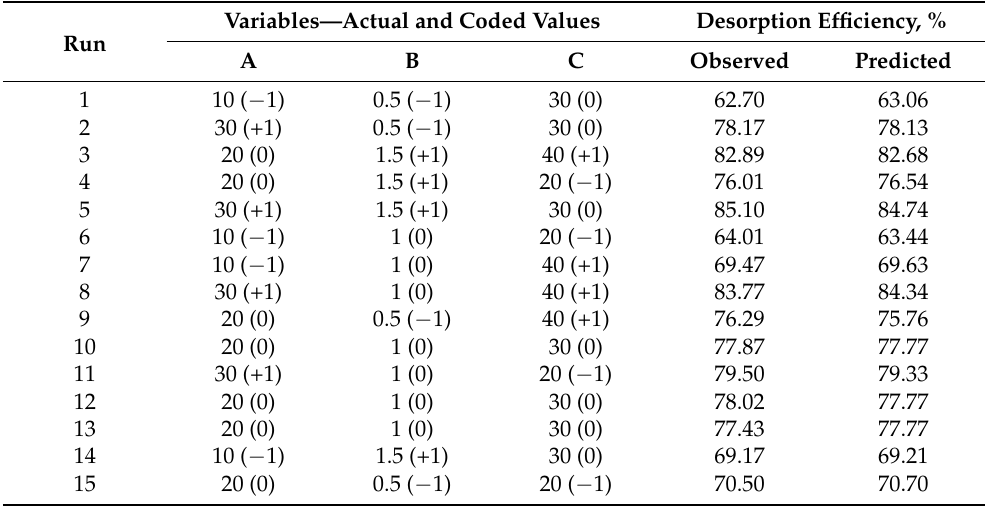
Table 1. RSM-BBD matrix comprising experimentally acquired and model-predicted records for the desorption of Reactive Black 5 dye from the prepared adsorbent.